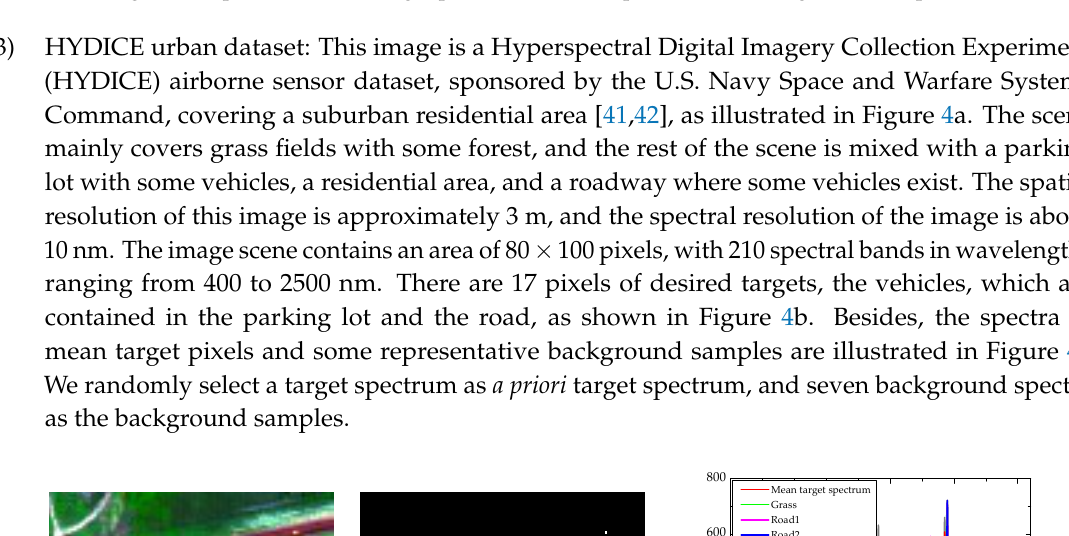
Figure 3. AVIRIS San Diego airport dataset for the experiment. ( a ) Image scene; ( b ) The true locations of the targets; ( c ) Spectra of mean target pixels and some representative background samples.